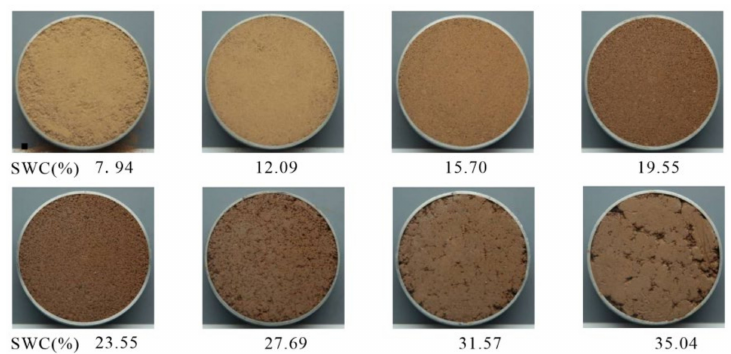
Figure 1. Digital images of expansive soil with different water contents.